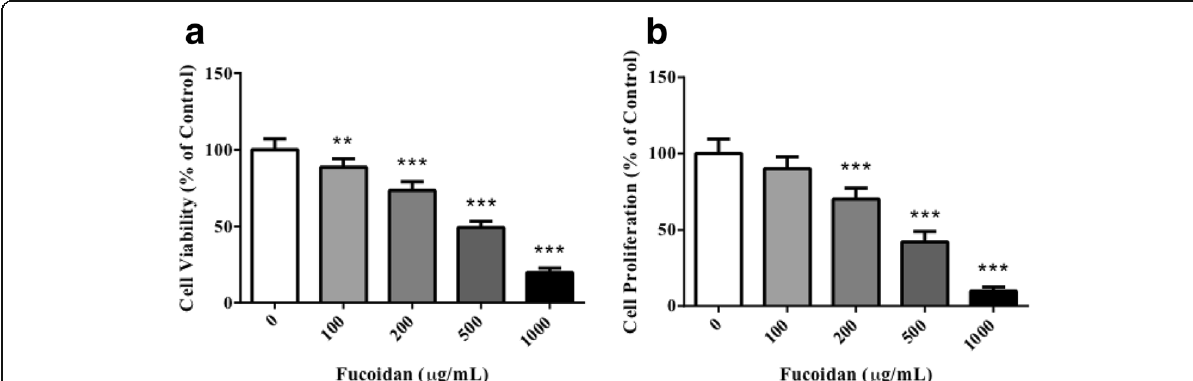
Fig. 1 Fucoidan inhibited viability and proliferation of prostate cancer cells. DU-145 cells were treated with 100, 200, 500, 1000 μ g/mL of fucoidan for 24 h. Cell viability ( a ) and proliferation ( b ) were measured by MTT and BrdU incorporation assay, respectively. ** P < 0.01 vs. control, *** P < 0.001 vs. control. All experiments were repeated at least three